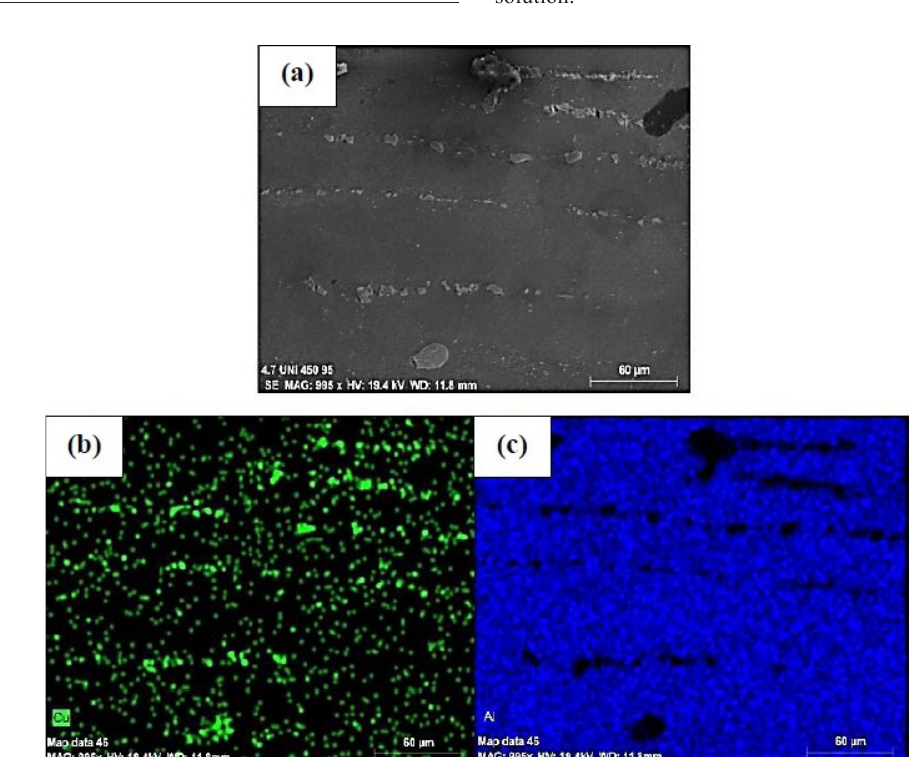
Figure 16. Al4.5wt%Cu alloy unidirectionally solidified with 91% of RA after heat treatment at 450 ºC and mapping